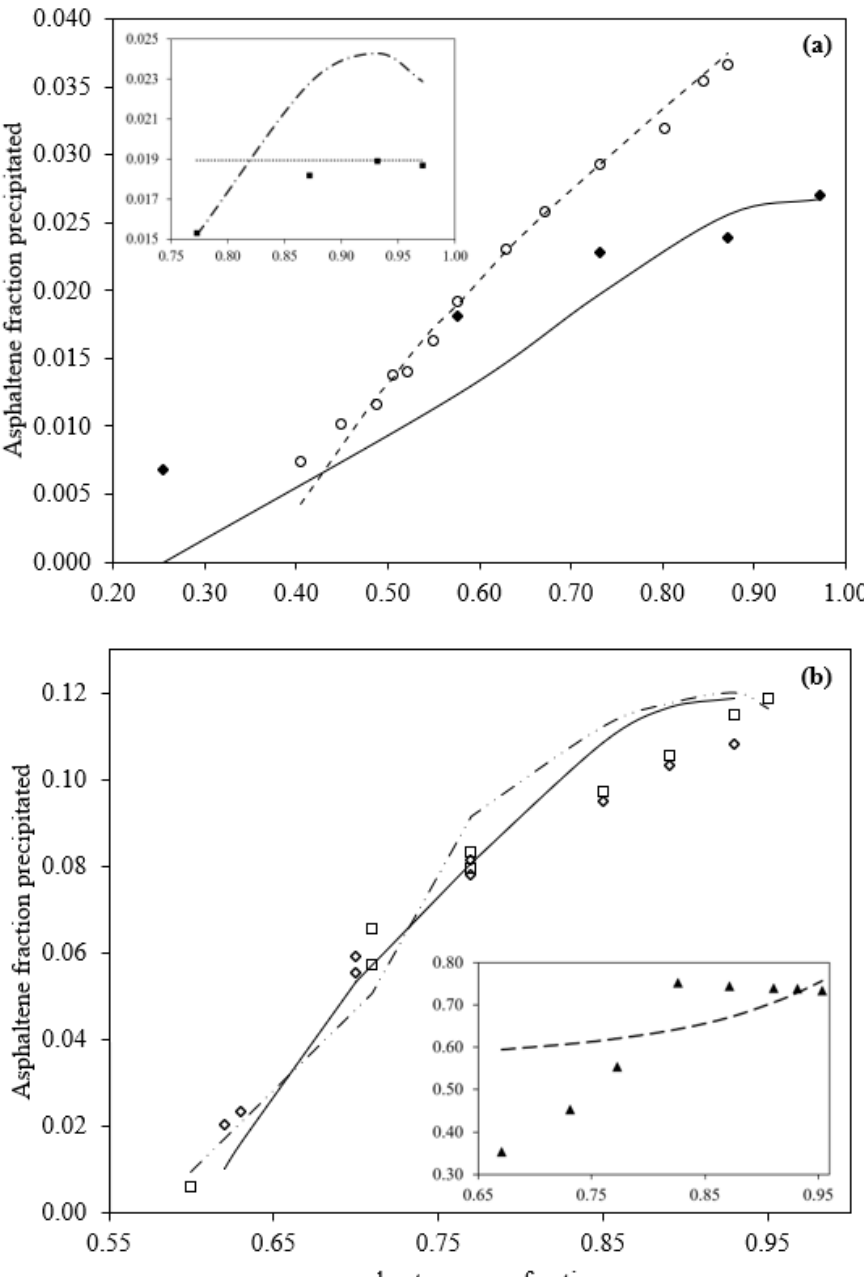
Figure 6. Effect of adding n-heptane solvent on precipitated asphaltene fraction. ( a ) Buenrostro et al., (for oil Y3: ◆ experimental, ━━ calculated), Rassamdana et al., ( ○ experimental, ━ ━ calculated), plot inside refers to: Experimental data ( ■ ) by Hirschberg et al., at 60 °C, (••••) calculated by Victorov and Firoozabadi, and ( ━ ･ ━ ) calculated by Kawanaka et al., ( b ) Sabbagh et al., (for Athabasca bitumen: □ experimental, — ·· — calculated, and for Cold lake bitumen: 3